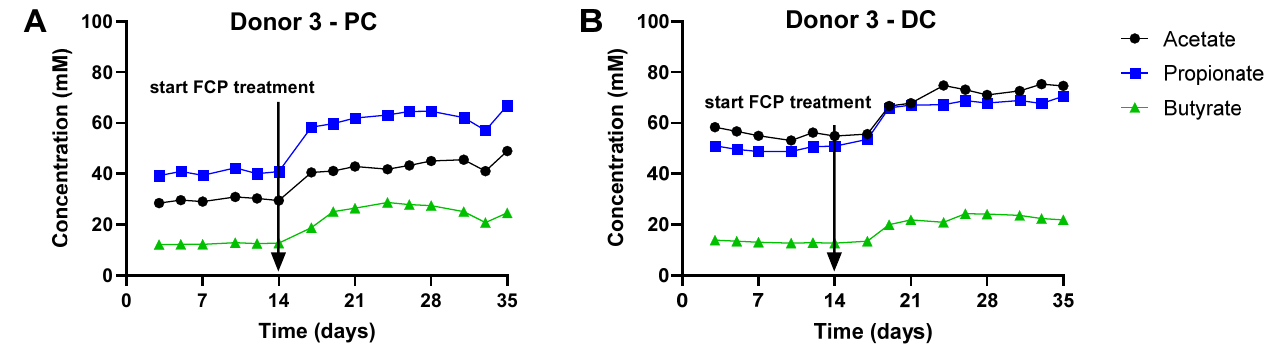
Figure 5. Effect of fermentation of FCP on SCFA levels (mM) in the simulated proximal colon ( A ) and distal colon ( B ) during both the control (Days 0–14) and treatment period (Days 14–35) of the triple-M-SHIME for donor 3. Results are representative of those obtained for Donors 2 and 4 (Supplementary Figure S1). Arrows indicate the start of the FCP treatment.